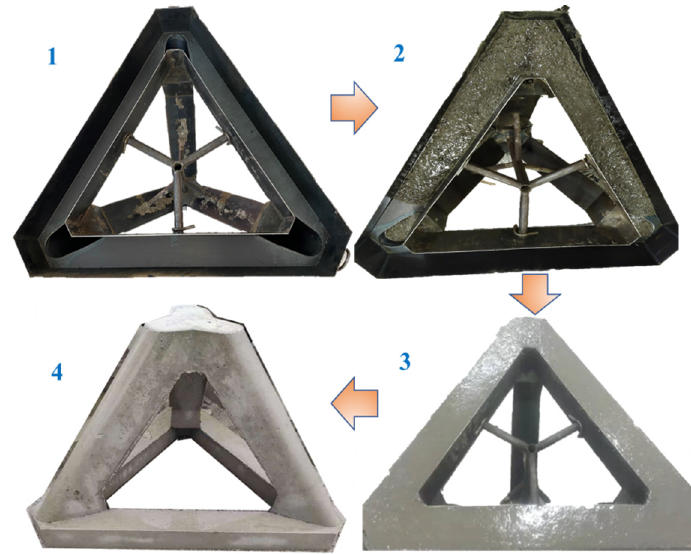
Figure 3. Casting process of pervious frame.